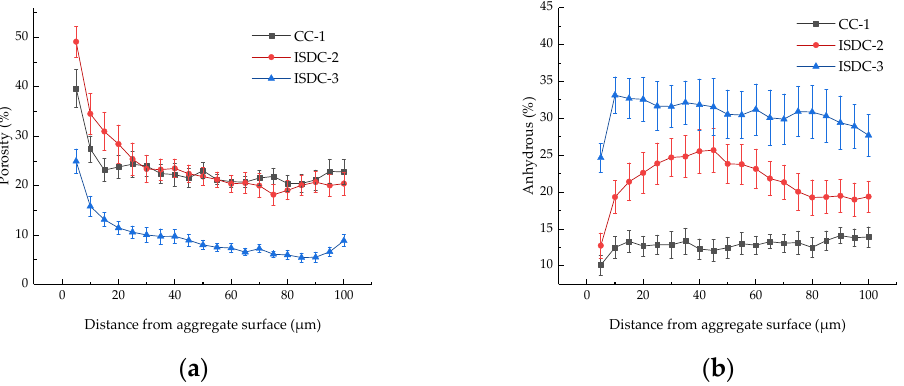
Figure 8. 28 d backscatter analysis of ( a ) CC ‐ 1, ( b ) ISDC ‐ 2, ( c ) ISDC ‐ 3 concrete.